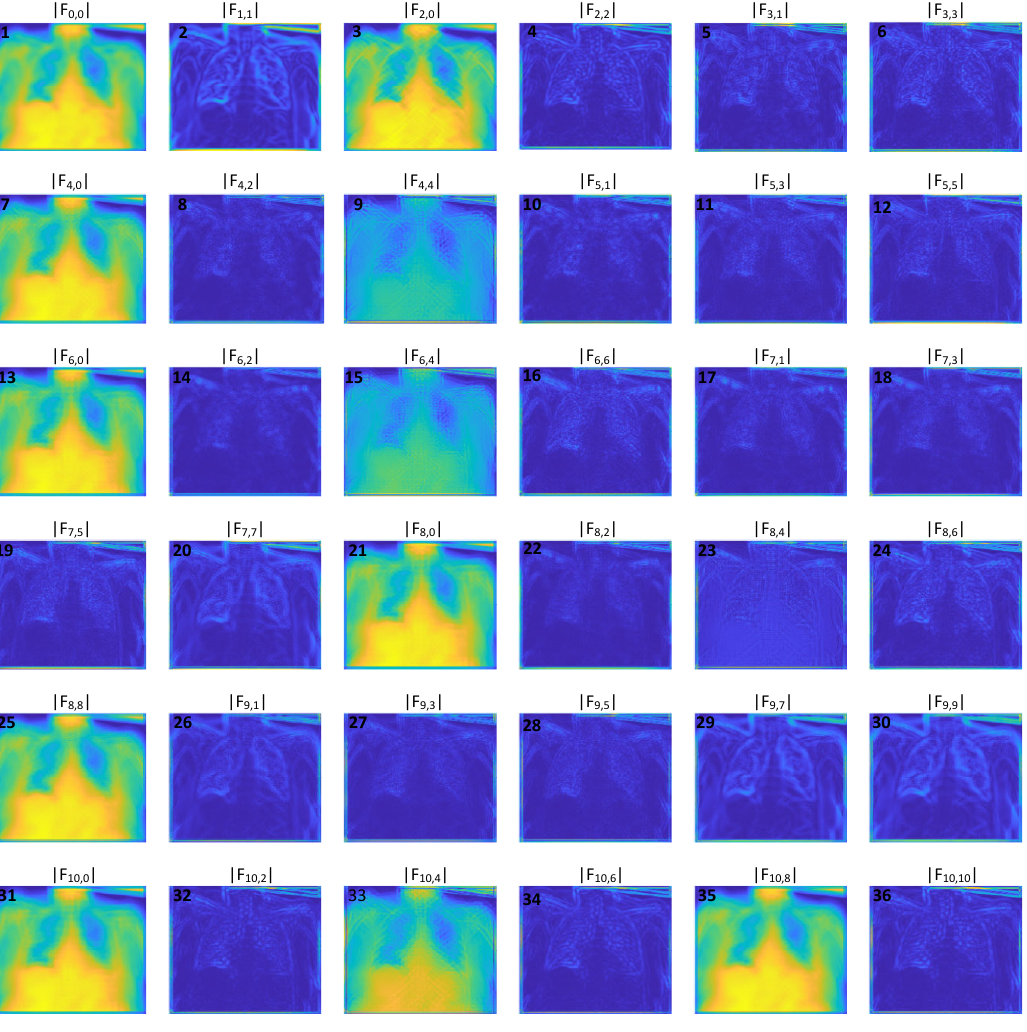
Figure 3. Visual representation of Zernike moment features with a combination of a different order, |F n,m |.